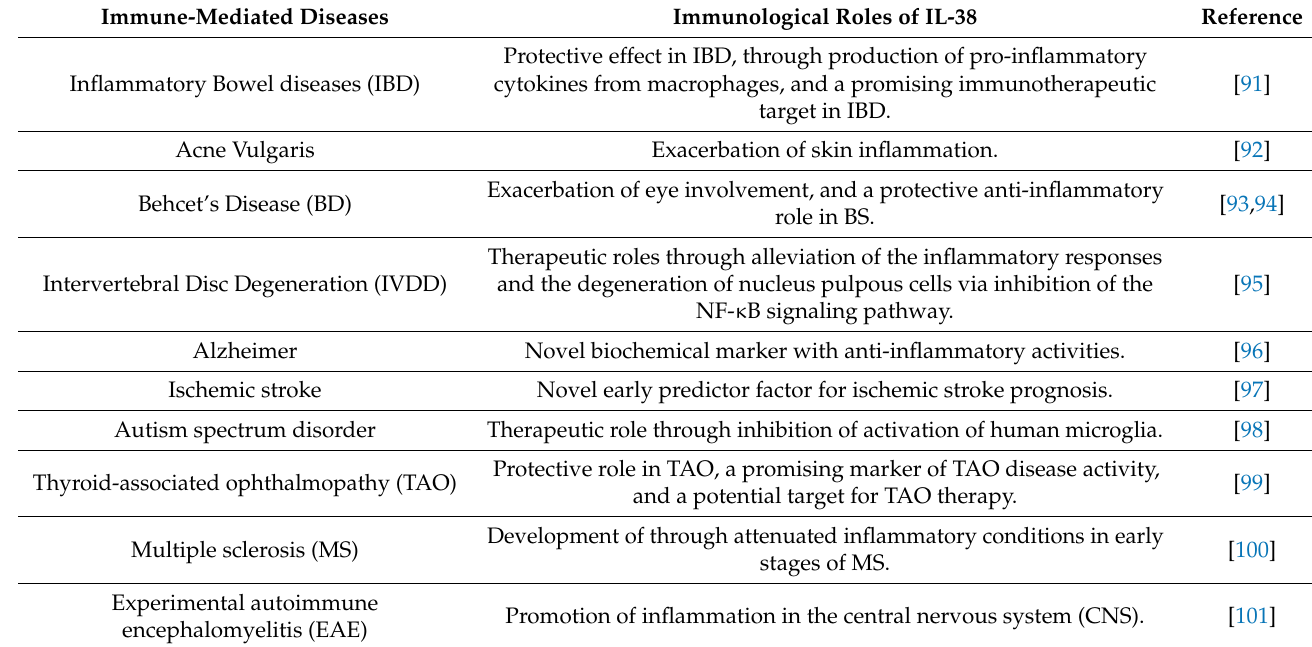
Table 1. Role of IL-38 in Immune-Mediated